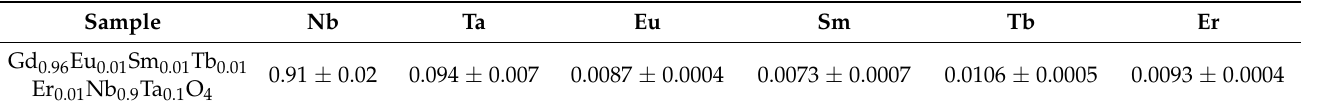
Table 2. Element composition of Gd 0.96 Eu 0.01 Sm 0.01 Tb 0.01 Er 0.01 Nb 0.9 Ta. 0.1 O 4 ceramic samples. The values are given in formulae